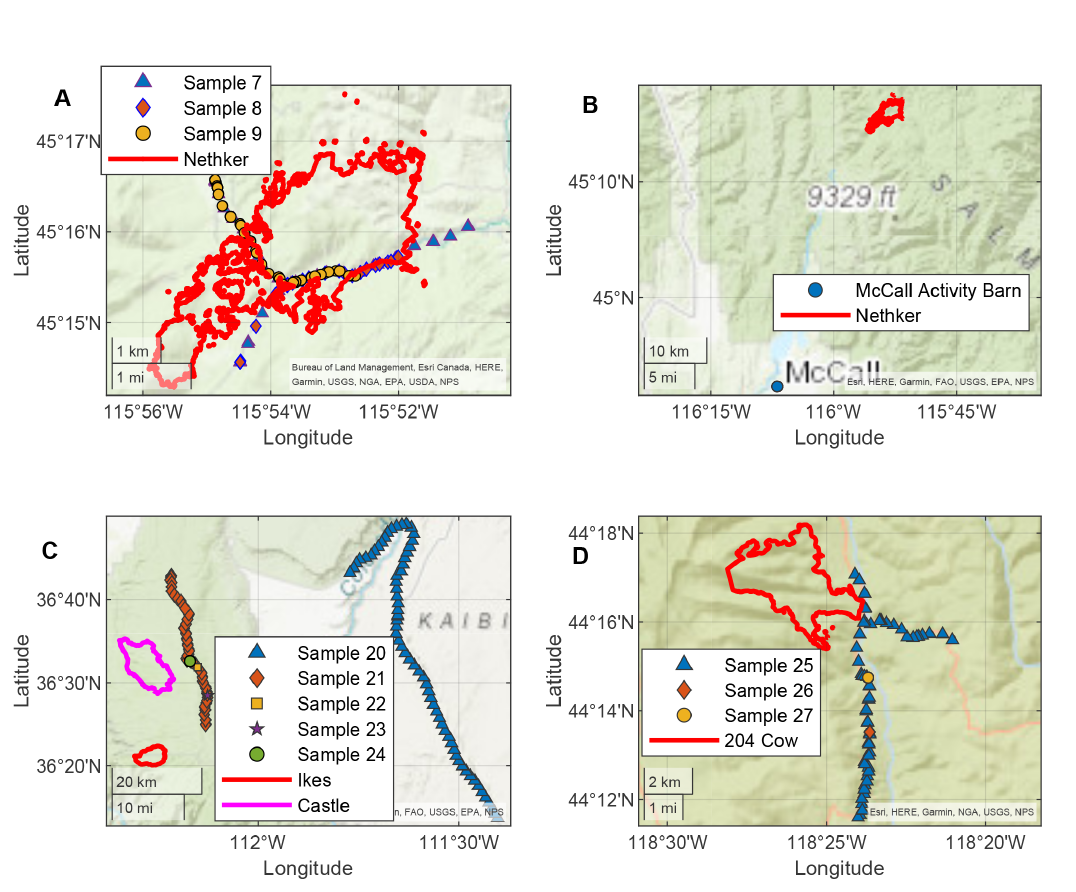
Figure 1. Locations of the AML (every minute) when hourly samples were collected and perimeters of the fires ( a and b Nethker Fires, c Arizona Fires, d 204 Cow Fire). The AML made multiple trips to the Nethker Fire. Only three samples are shown here as examples. Fire perimeters shown here are the perimeters on or closest to the date when the samples were